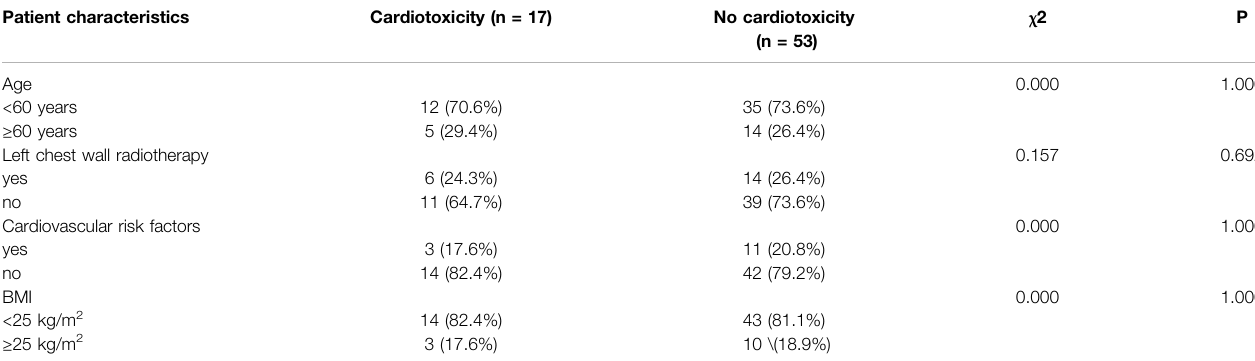
TABLE 5 | Univariate chi-square analyses for in fl uencing factors of subclinical cardiotoxicity according to patients ’ characteristics. Patient characteristics